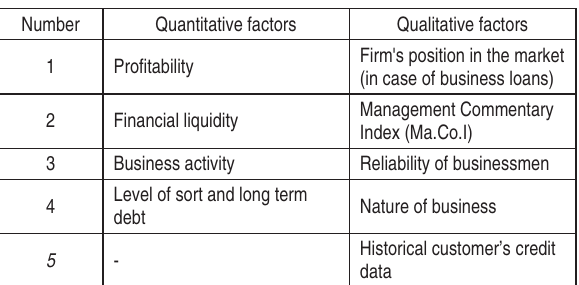
Table 2. Areas of business